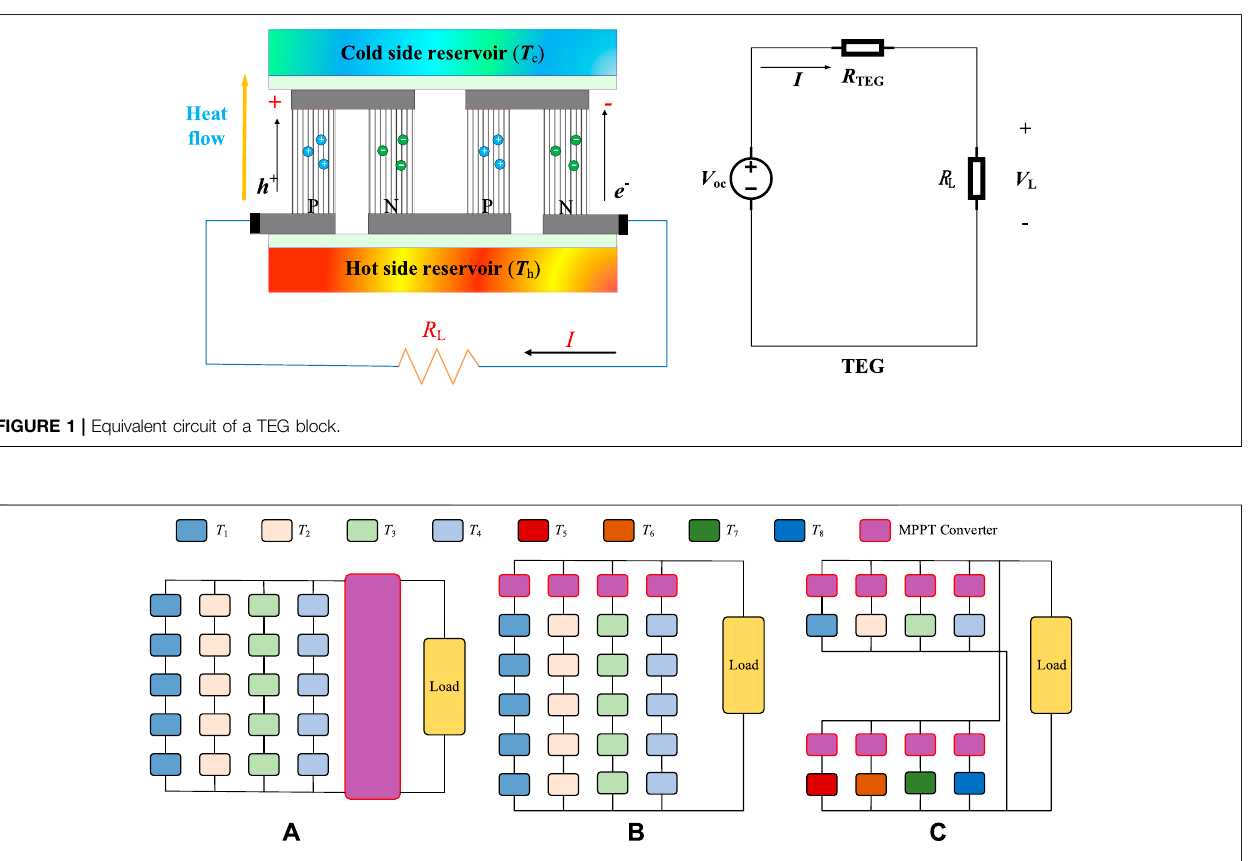
FIGURE 2 | Three classic architectures of the TEG systems: (A) integrated, (B) tandem-type, and (C) modular.